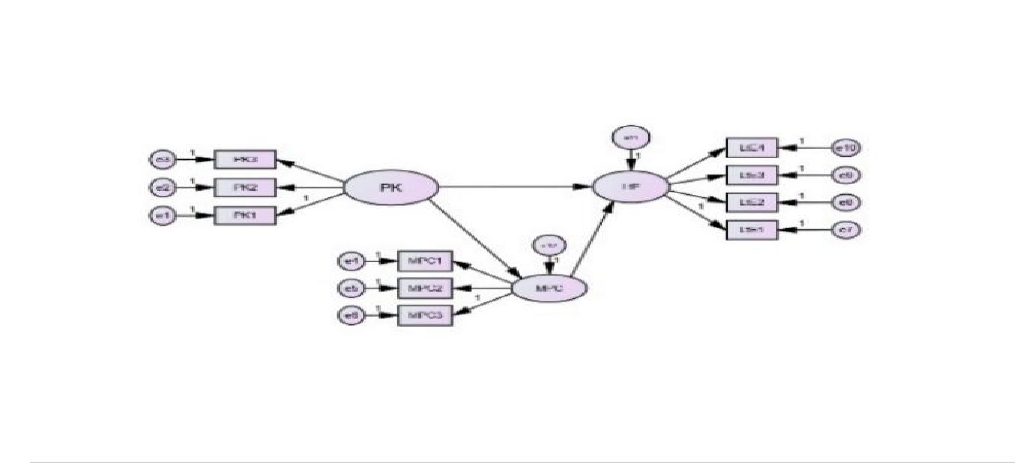
Figure 1. Research Constellation Model